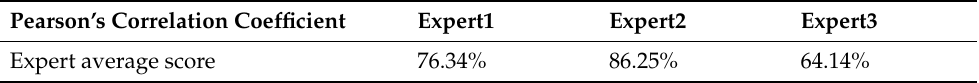
Table 2. Correlation coefficients for scoring the fluency between experts on the PSCPSF.